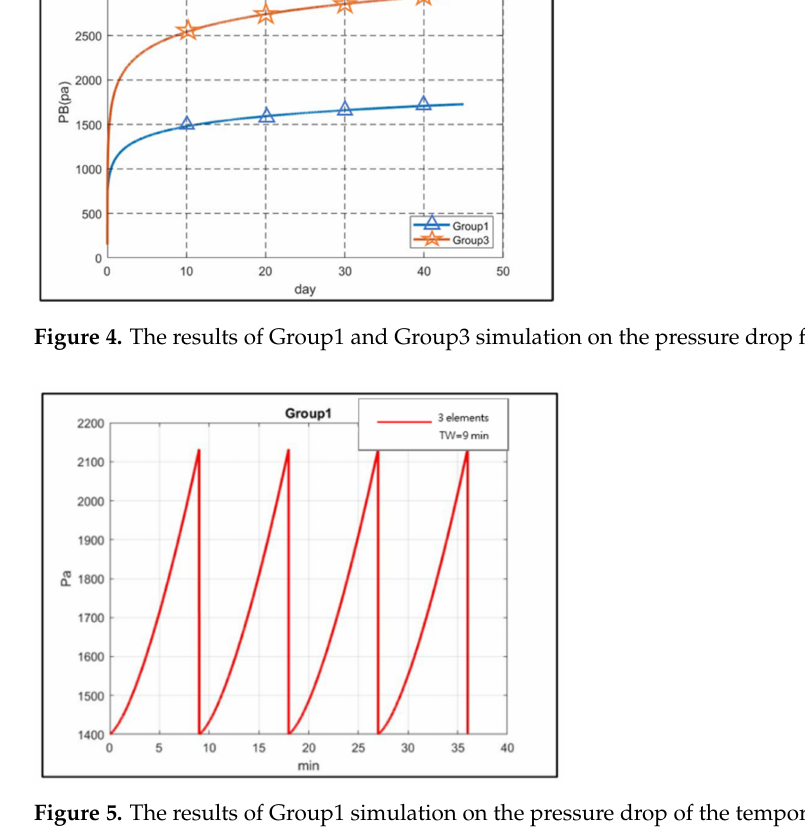
Figure 5. The results of Group1 simulation on the pressure drop of the temporary powder cake.